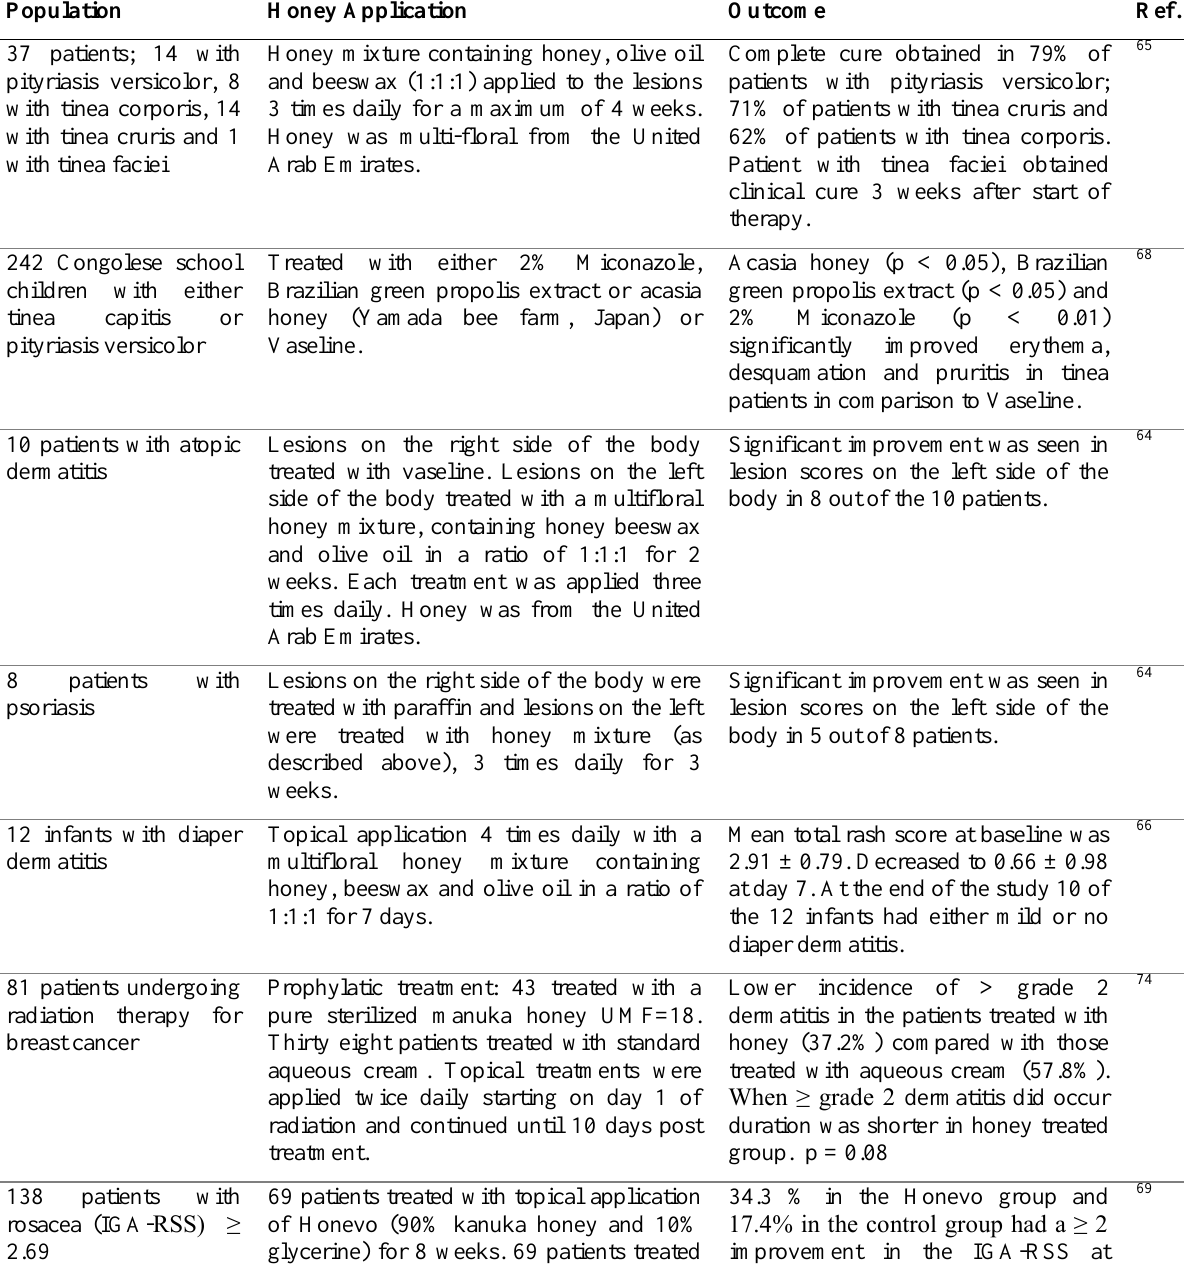
Table 3: Studies investigating the efficacy of honey in the treatment of skin disorders (excluding wounds) Population Honey Application Outcome